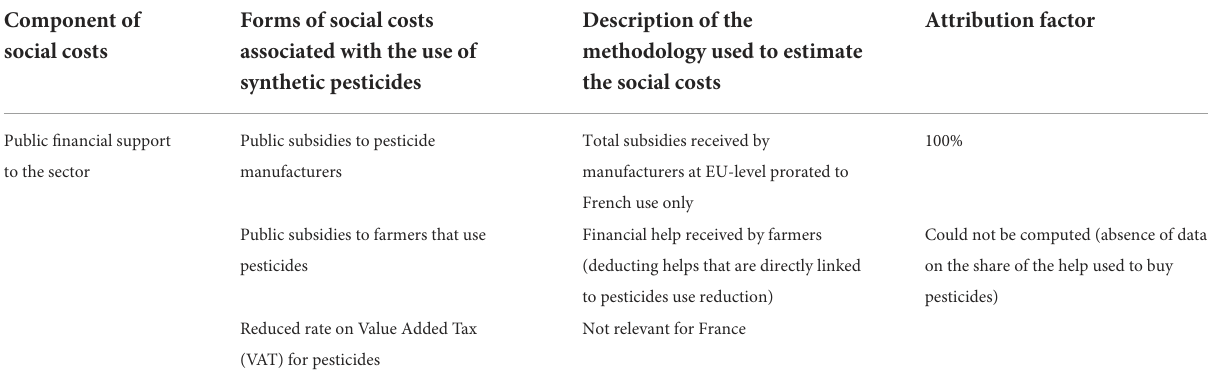
TABLE 4 Forms and description of the public financial support to the sector of synthetic pesticides in France. Component